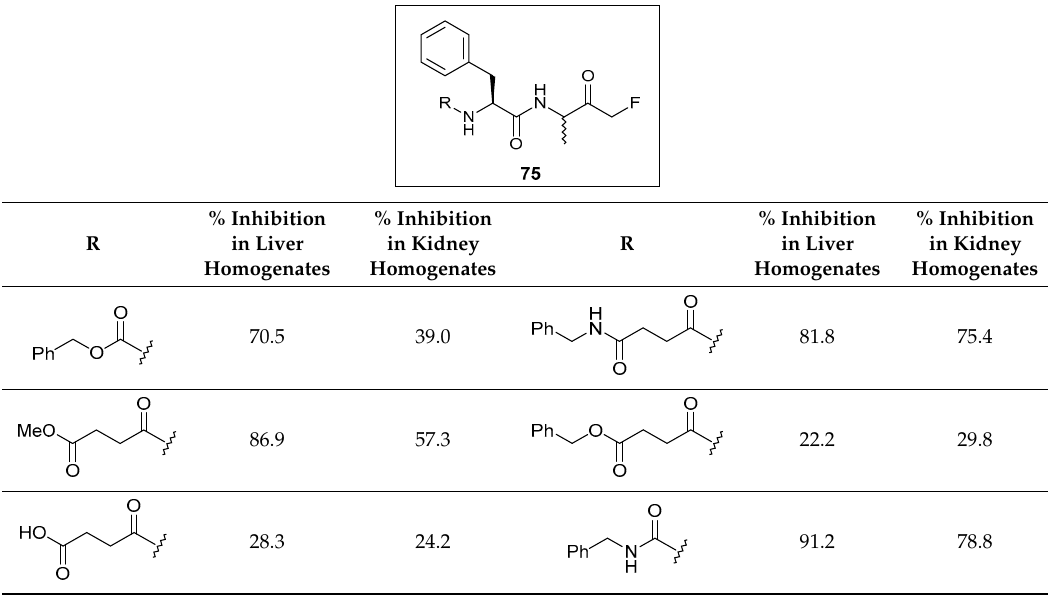
Figure 3. Peptidyl FMKs capable of inhibiting calpain I [2].